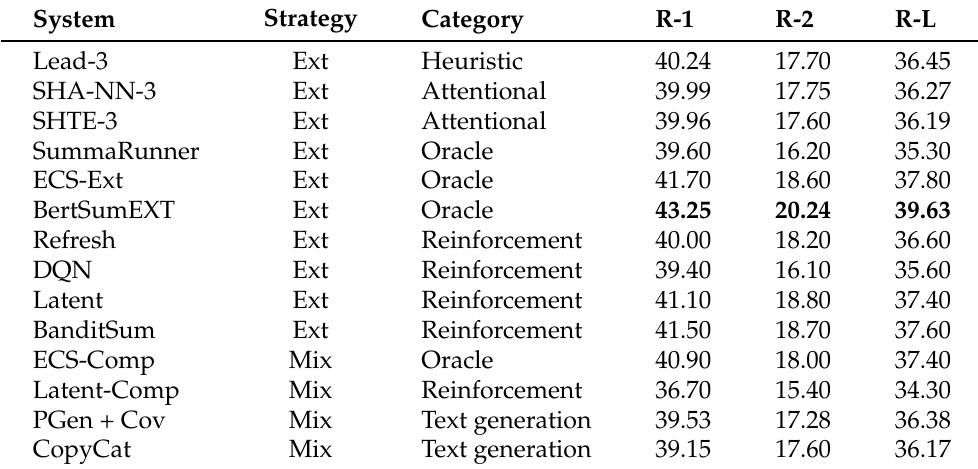
Table 2. Results on CNN/DailyMail corpus for full-length Rouge. The suffix of Lead, SHA-NN, and SHTE models refers to the number of extracted sentences, k . Best results are in bold.